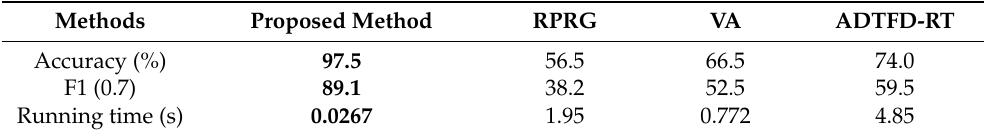
Table 4. Experimental results of different methods.